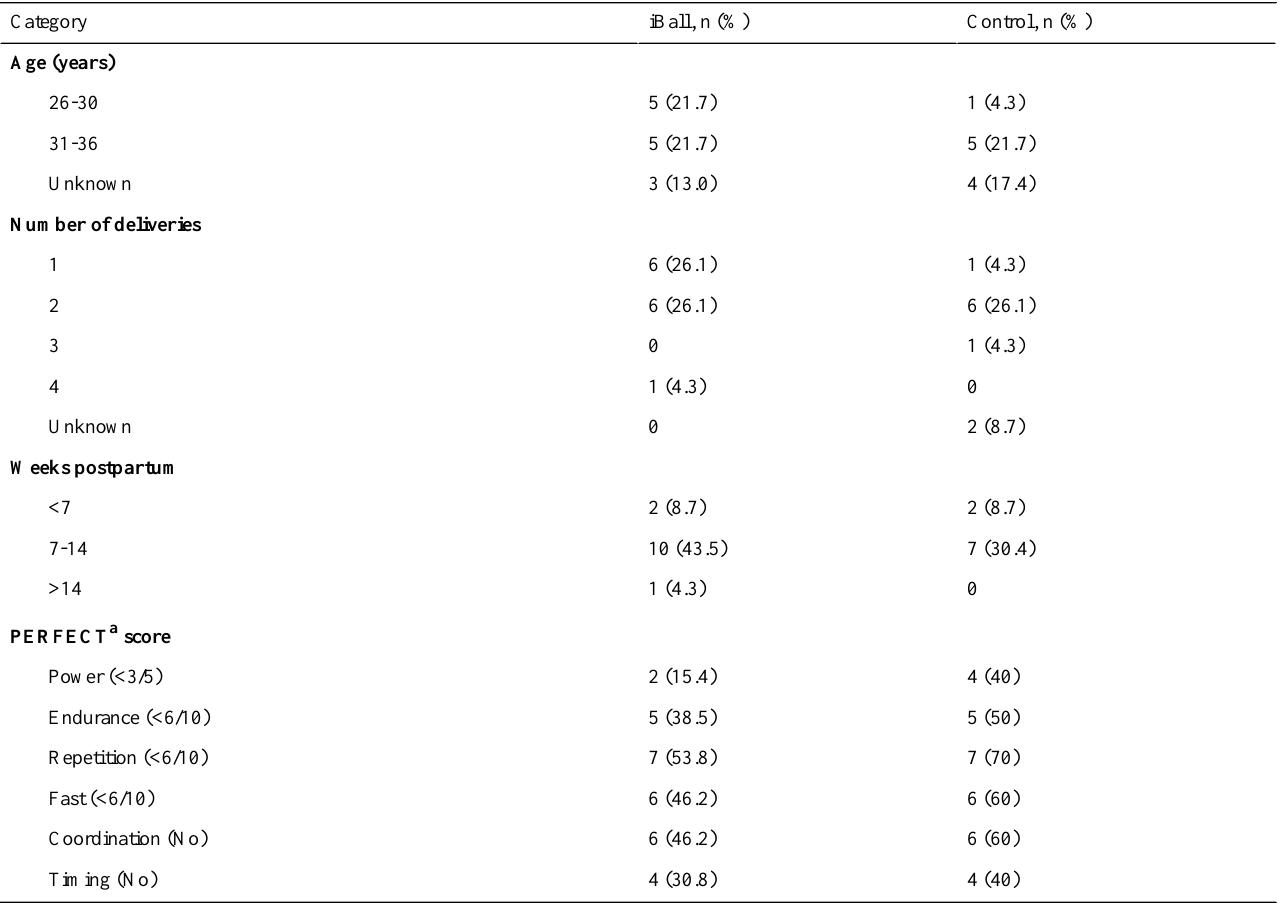
Table 1. Baseline characteristics and participant